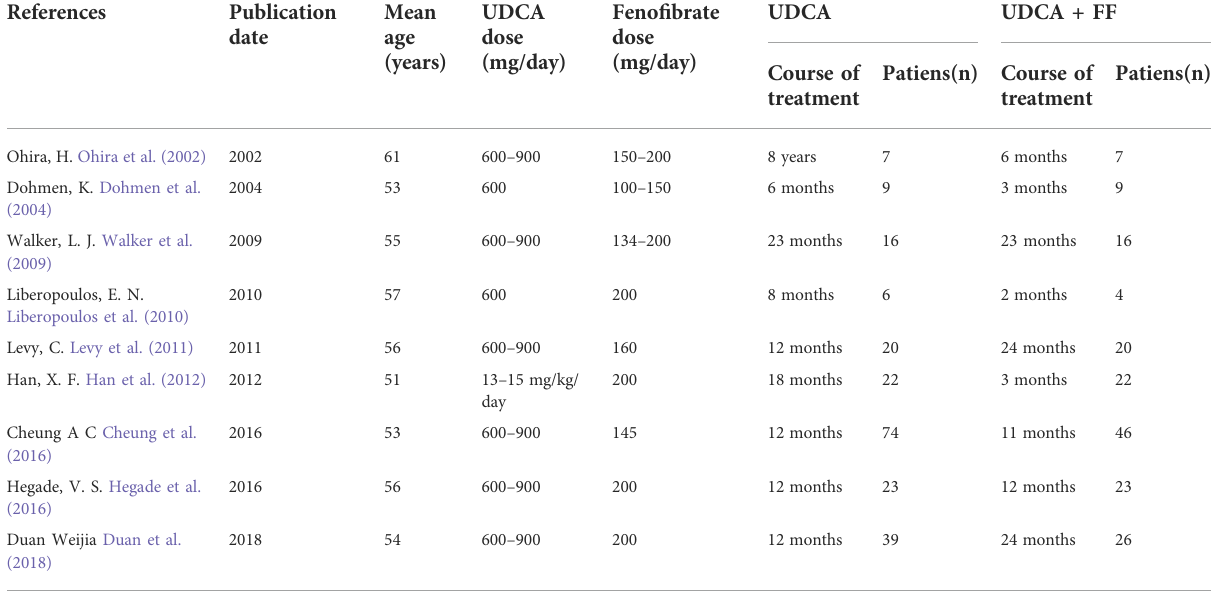
TABLE 1 Baseline characteristics of the trials included in the meta-analysis.